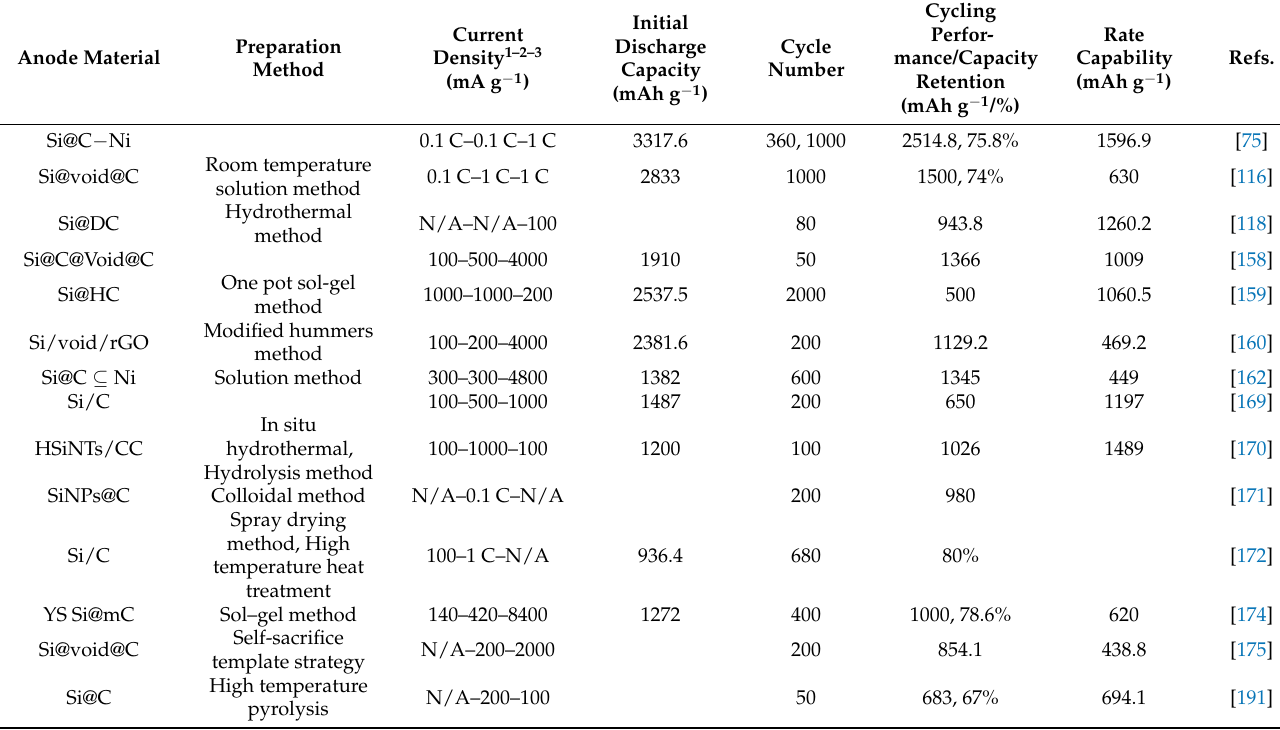
Table 2. Electrochemical performance of hollow core-shell silicon/carbon anodes for